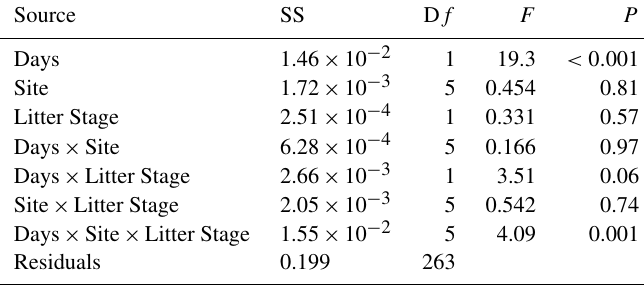
Table A1. ANOVA table of general mass loss model showing three-way interaction between time, site, and litter